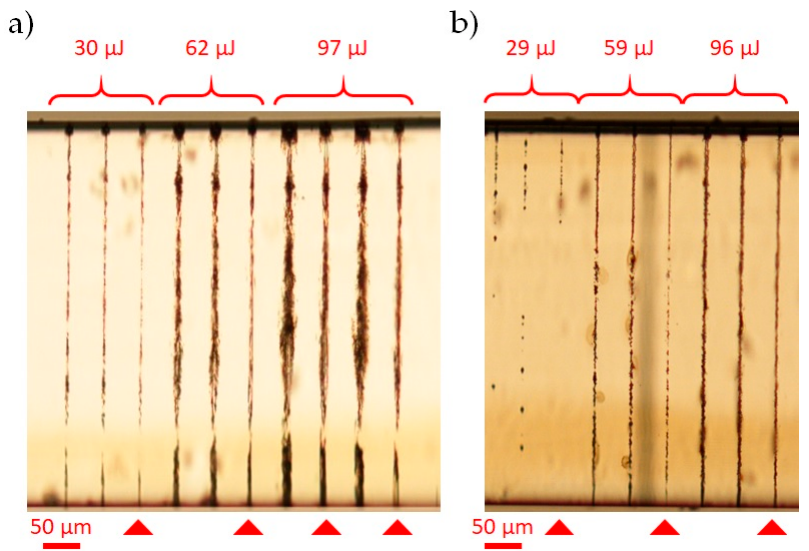
Figure 10. Optical microscope images of microstructures generated in single- (triangles) and four- shots damages in a 500 μ m-thick PMMA sample with BB pulse duration of 1 ps ( a ) and 18 ps ( b ) and different energies.